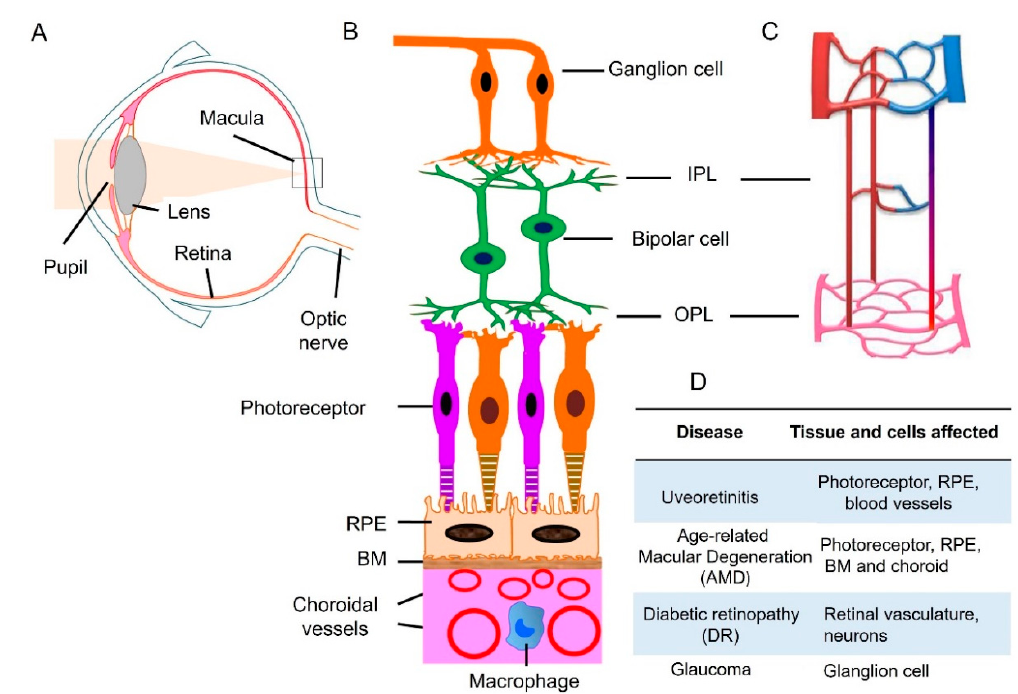
Figure 1. Retinal neuronal and vascular structure and retinal disease. ( A ) Diagram of a human eye. Light passes through the pupil and is focused by lens onto macula of the retinal layer at the back of the eye. ( B ) Retina consists of three layers of neurons, photoreceptor, bipolar, and ganglion cells. The retinal pigment epithelial (RPE) monolayer together with Bruch's membrane (BM) form outer blood retinal barrier that separates the neuroretina from the choroid. Choroidal circulation provides oxygen and nutrients to outer retina. ( C ) The retina has an interconnected network of three vascular layers located in the ganglion cell/nerve fiber layer, inner plexiform layer (IPL), and outer plexiform layer (OPL). ( D ) retinal tissue and cells that are affected under different disease conditions. Adapted from reference [17].